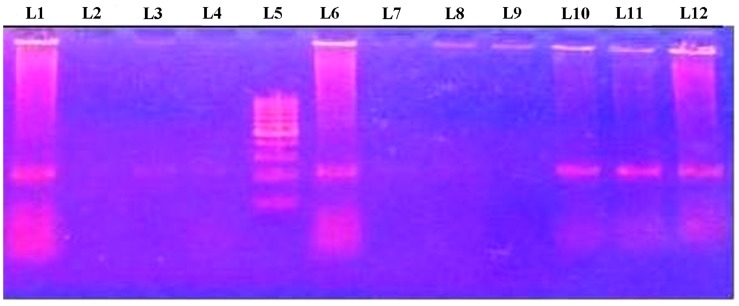
RT PCR of RNA from treated and untreated cattle.Lane L1: RB51 lysate immunized animal no. 1 on zero day; L2: RB51 lysate immunized animal no. 1 on 90th day post-immunization; L3: RB51 lysate immunized animal no. 2 on 90th day post-immunization; L4: RB51 lysate immunized animal no. 3 on 90th day post-immunization; L5: Marker ladder; L6: Cocktail (S19+RB51) lysate immunized animal no. 1 on zero day; L7: Cocktail (S19+RB51) lysate immunized animal no. 1 on 90th day post-immunization; L8: Cocktail (S19+RB51) lysate immunized animal no. 2 on 90th day post-immunization; L9: Cocktail (S19+RB51) lysate immunized animal no. 3 on 90th day post-immunization; L10: Untreated control animal no. 1 on zero day; L11: Untreated control animal no. 1 on 90th day; L12 Untreated control animal no. 2 on 90th day.